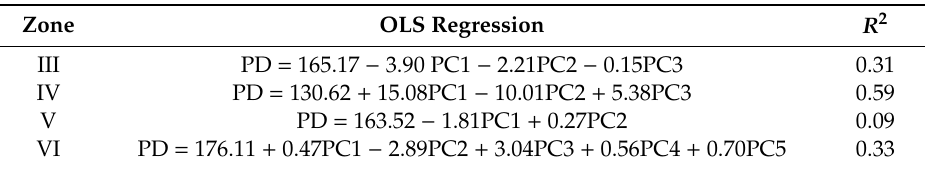
Table 5. OLS regression for summer maize in each zone. R 2 is the adjust coe ffi cient of determination. PD is planting date (day of